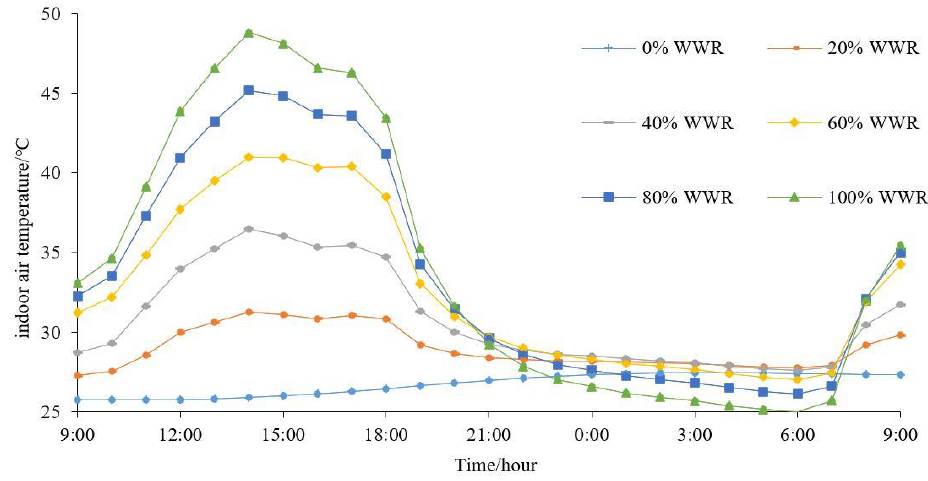
Figure 10. The daily variations of the indoor air temperatures of the six WWRs.